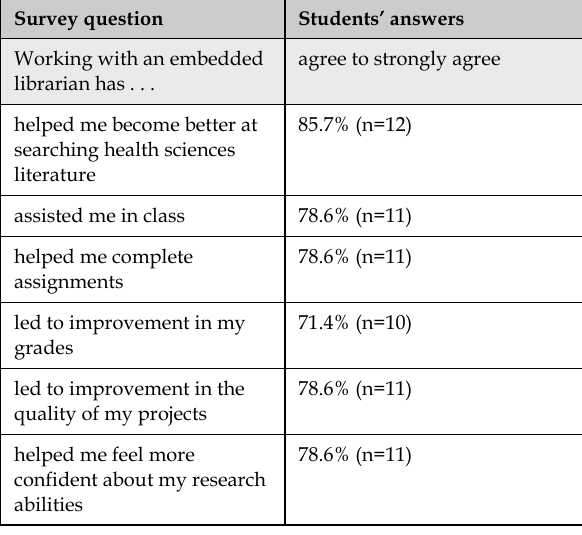
Table 1 Embedded librarian project Likert survey results